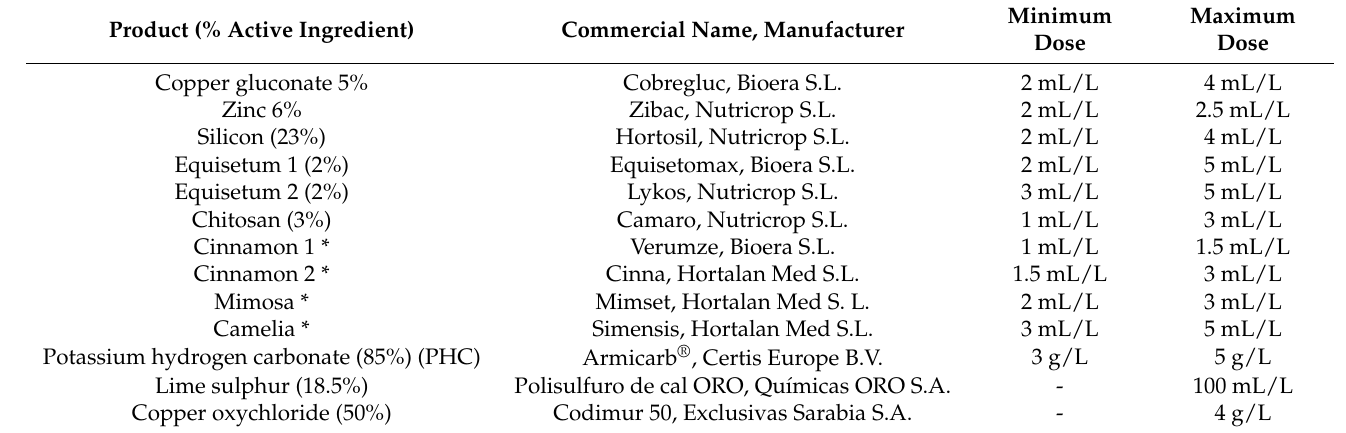
Table 1. Concentrations of the products (formulations) tested for the in vitro screening of alternatives to copper as fungicides against Botrytis cinerea